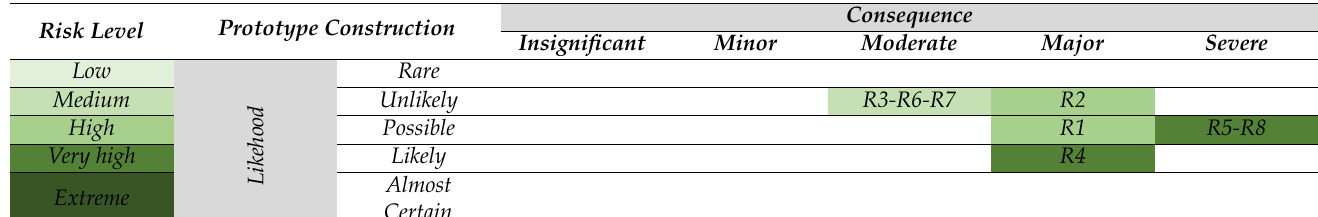
Table 2. Evaluation of main risks affecting the CSP–CaL prototype construction.